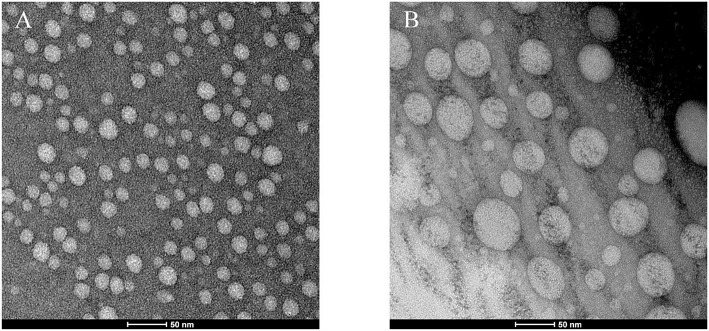
TEM images of blank micelles (FA-CA) (A) and DOX-loaded micelles (FA-CA-DOX) (B).